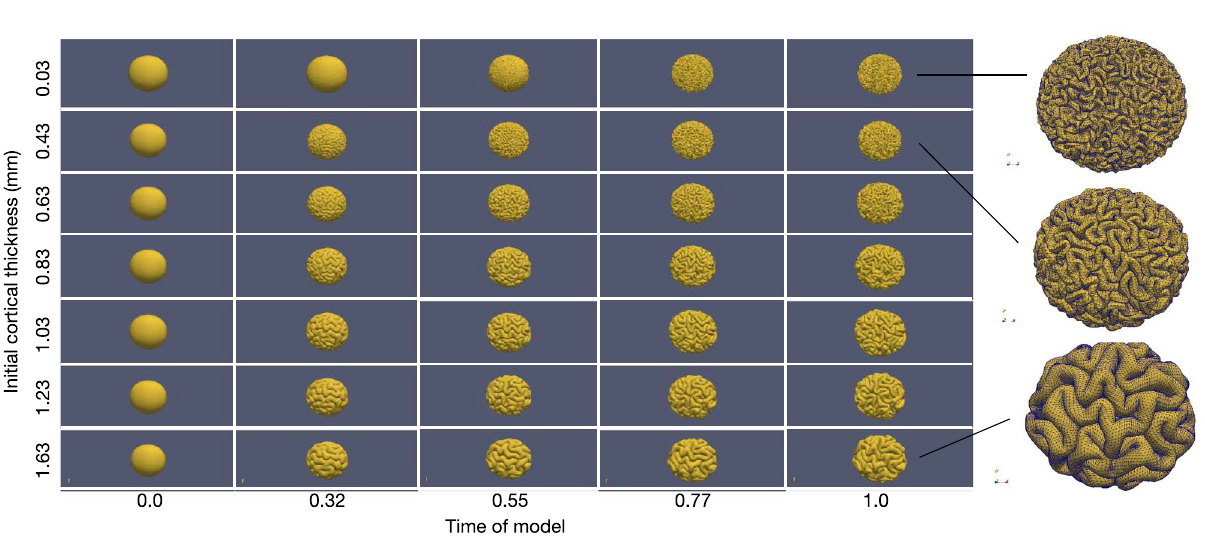
Figure 4. The comparison of folding patterns on different geometries with the same initial cortical thickness. Software: ParaView-5.8.0, https:// www. parav iew. org/.